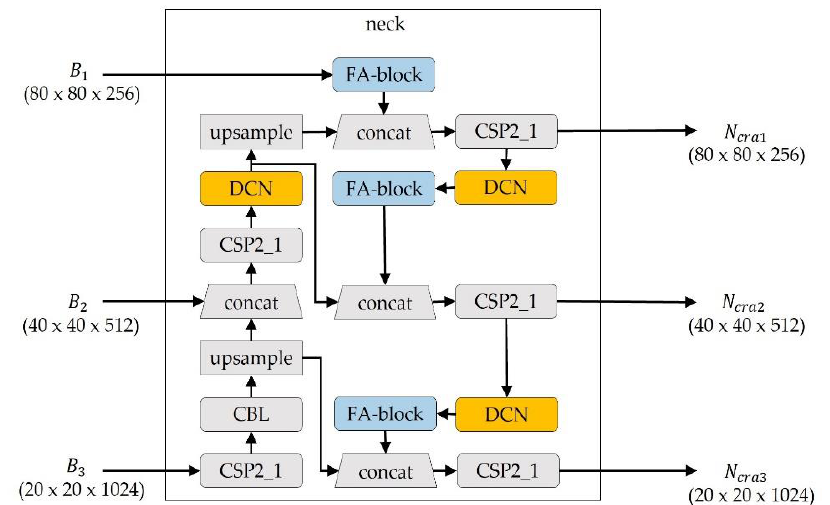
Figure 3. Neck module for cracks.